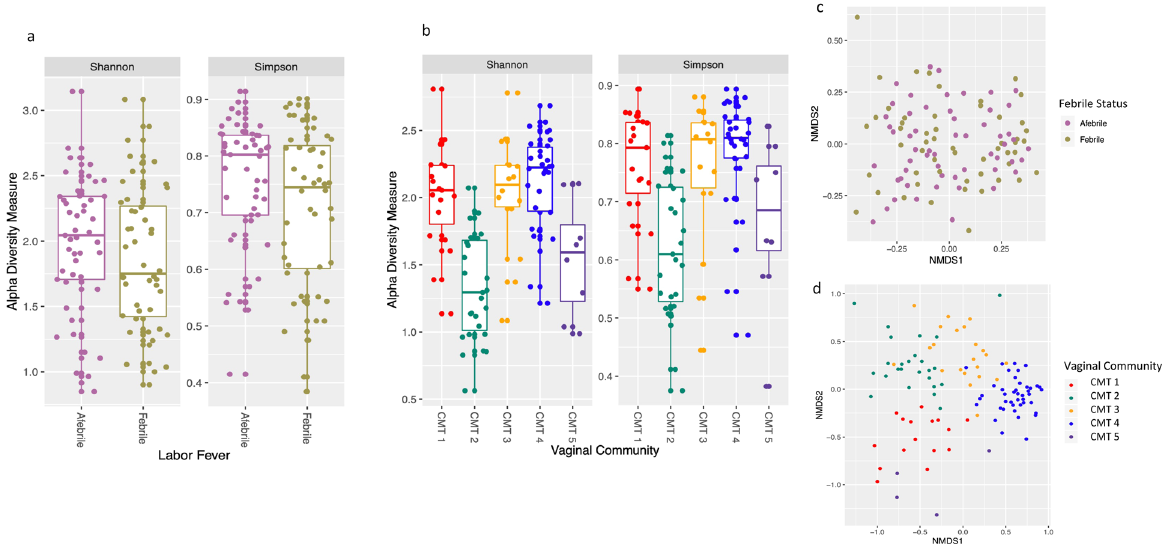
Fig. 3 Structure of vaginal microbiome based on diversity estimates. a α -Diversity estimation (Shannon, Simpson) jitter boxplot of maternal cohort when fever status is considered utilizing V3 – V4 regions (upper and lower quartiles are shown by whiskers and center line represents the median α -diversity). b α -Diversity estimation, jitter boxplot of maternal cohort when sample community assignment is taken into account; CMT denotes community (1 – 5) (upper and lower quartiles are shown by whiskers and center line represents the median α -diversity). c β -Diversity of maternal sample cohort shown by non-metric multidimensional scaling (NMDS). Samples are colored based on the maternal fever status (febrile, afebrile), goodness of fi t stress = 0.2. d β -Diversity of maternal sample cohort by NMDS. Samples are colored by community assignment through hierarchical clustering goodness of fi t stress =